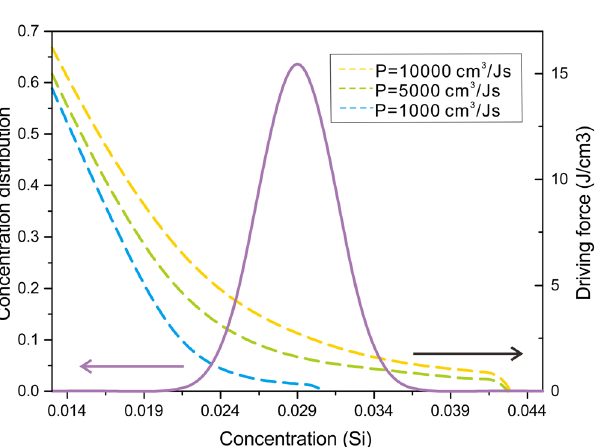
Figure 5. Concentration distribution in the melt and nucleation driving force with respect to different